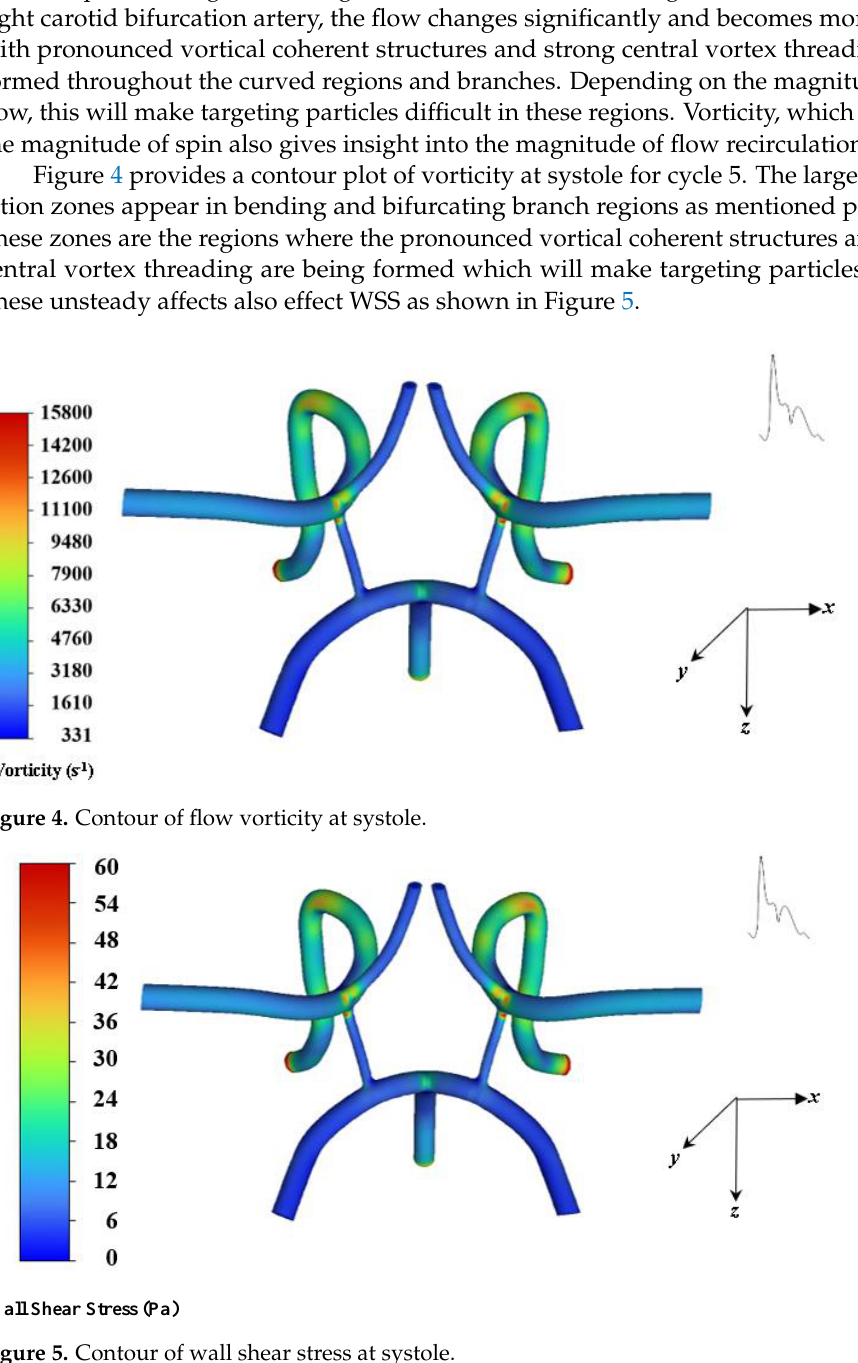
Figure 3. Velocity profiles at the cerebral artery branch contour segment at systole and diastole.